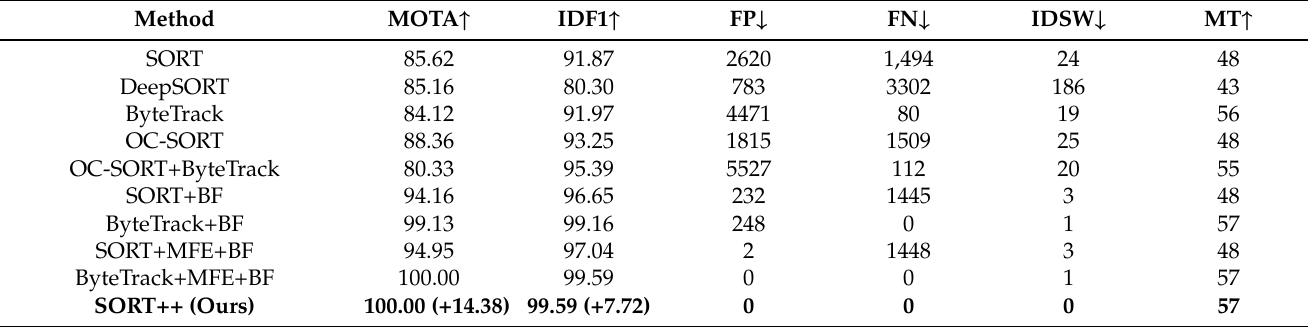
Table 8. Comparison of the state-of-the-art methods on the Test0 (Sunny) set.